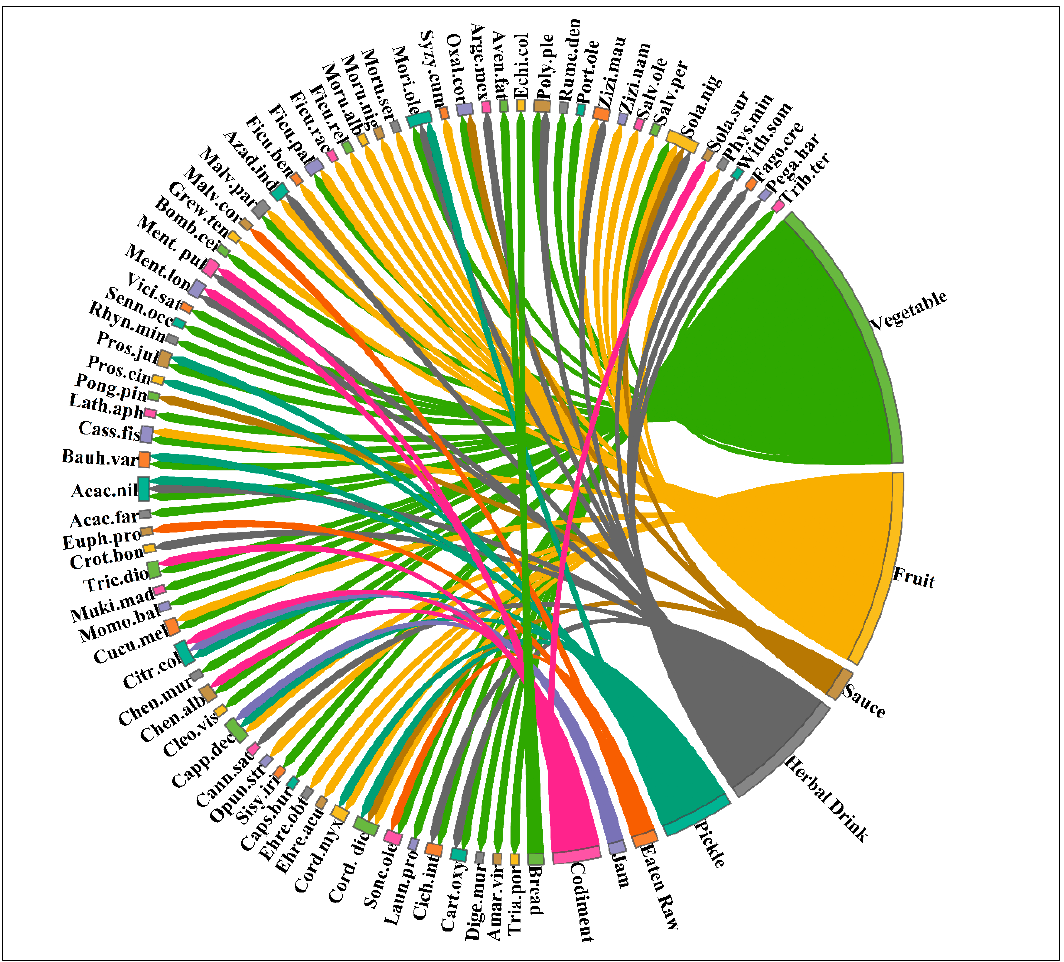
Figure 2. Chord diagram representing the consumption mode and species of recorded WFPs from the Indo–Pak border in Pakistan.